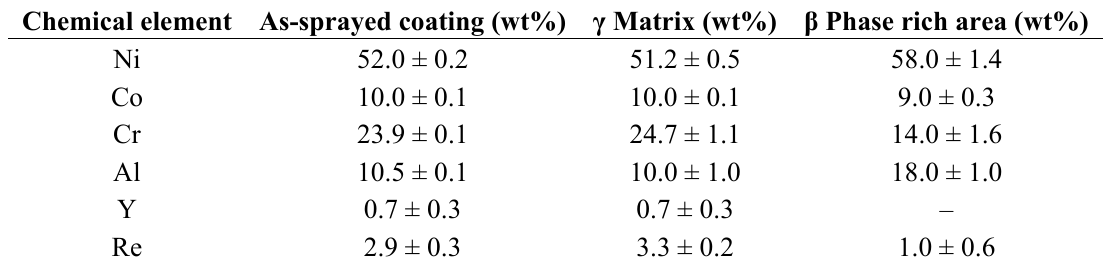
Table 2. Chemical composition of as-sprayed NiCoCrAlYRe coating, matrix and β -rich areas. Chemical